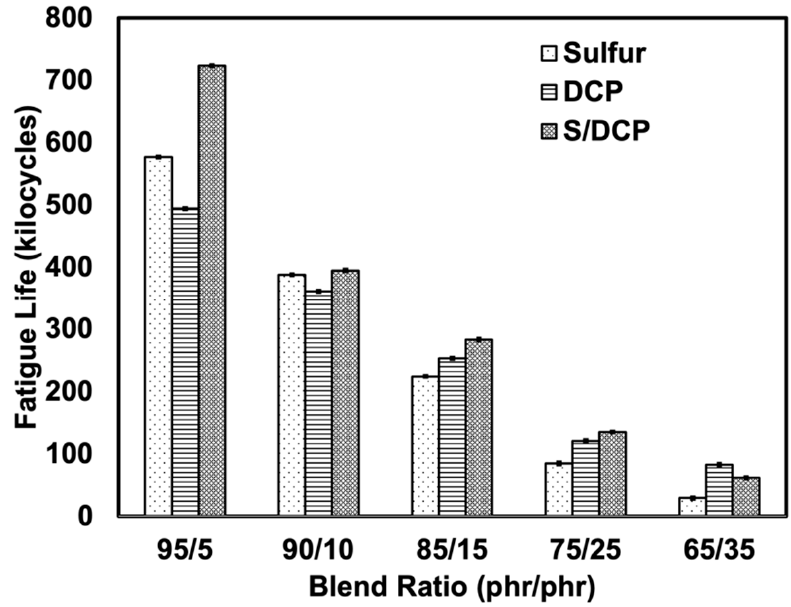
Figure 8. Fatigue life of NR/r-NBR blends with various crosslinking systems.